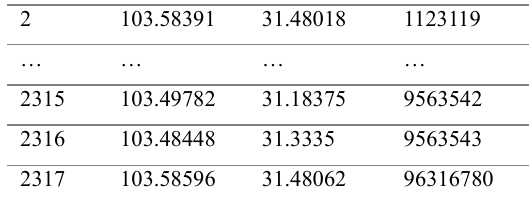
Table 1 . Examples of residential points.